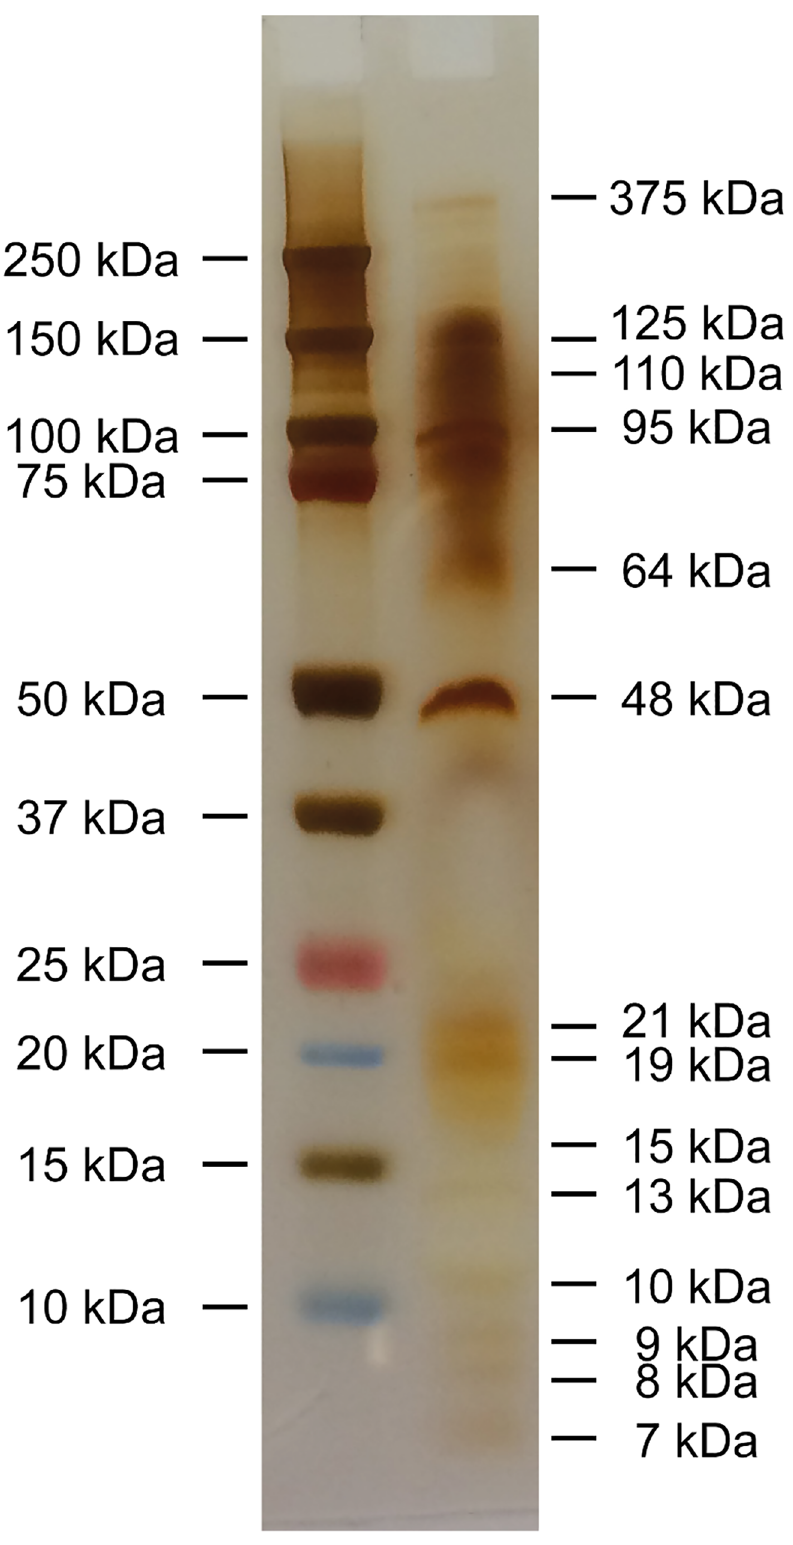
Fig 1. SDS-PAGE of the isolated ES proteins from C . osculatum third-stage larvae; reducing condition, silver staining; Left column: MarkerPrecision Plus Protein TM Dual Color Standards; Right column: C . osculatum ES proteins with different molecular